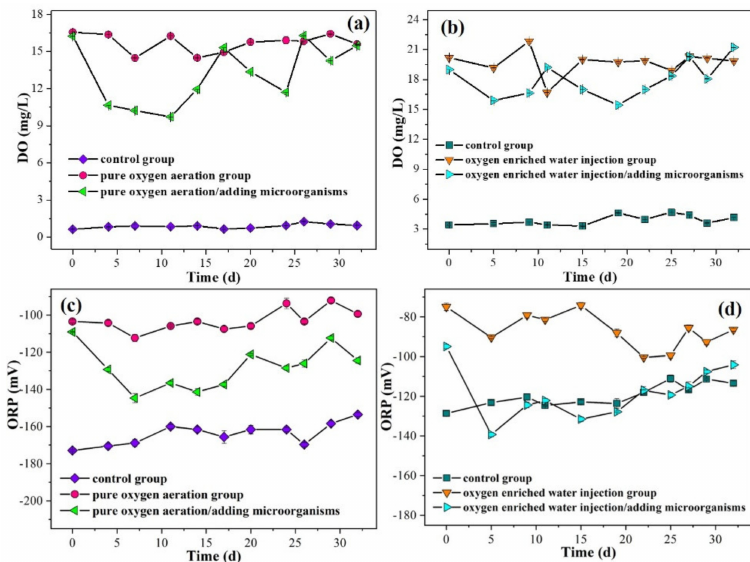
Figure 7. The changes of the DO concentration in the sediment during ( a ) pure oxygen aeration treatment and ( b ) oxygen enriched water injection treatment after adding microorganisms; the changes of the ORP in the sediment during ( c ) pure oxygen aeration treatment and ( d ) oxygen enriched water injection treatment after adding microorganisms.